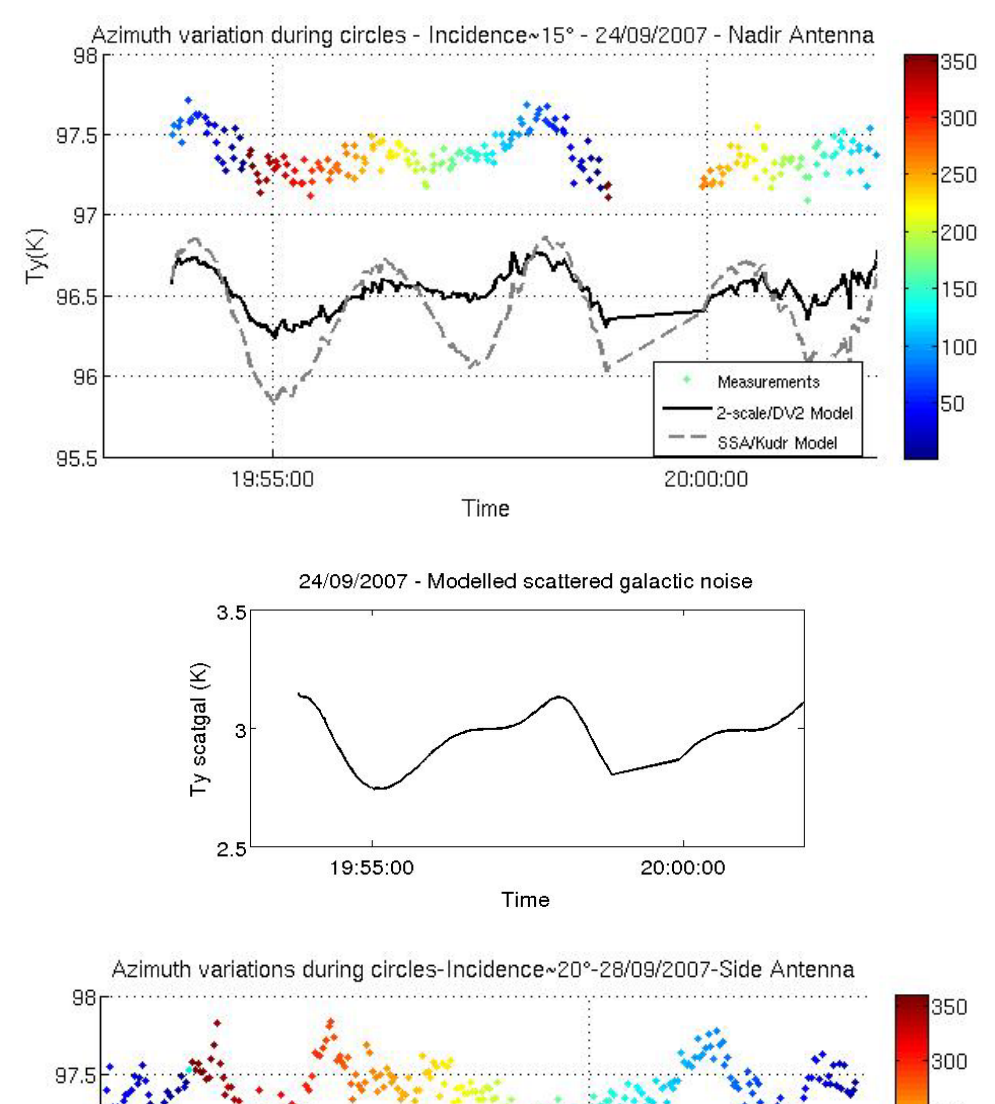
Figure 9. Top: Variations in Ty (1s averages) as observed (colored points), and simulated using the 2scale/DV2 (black) and SSA/Kudr. (grey) models during three circular flights. The azimuth angle is color coded. Bottom: Modeled variations of scattered galactic noise. Left: nadir antenna on 24/09/07; wind speed of 8.3 m/s. Right: side antenna on 28/09/07; wind speed of 8.4 m/s. (a bias has been artificially added to the measurements, to facilitate visual